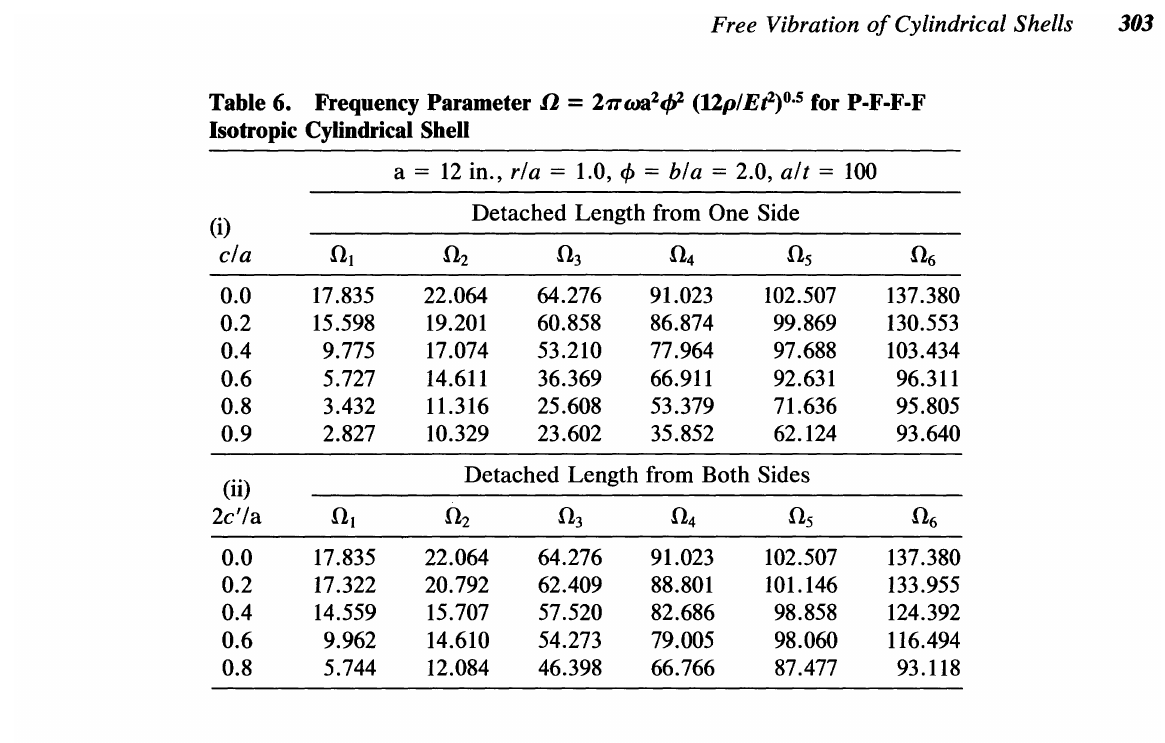
= 4Jl (12pIEP)o.s for P·F·F·F 2'1T6I8 z